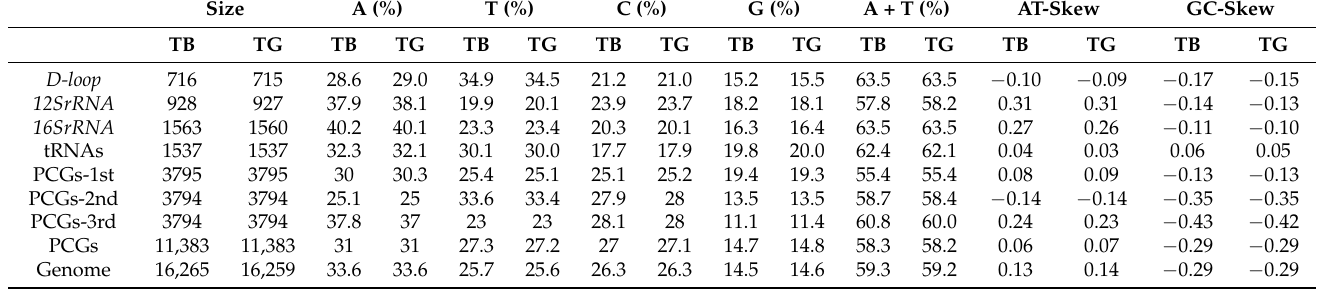
Table 3. Nucleotide composition and skewness of the mitogenomes of T. broadoridgus (TB) and T. gaowangjienensis (TG).